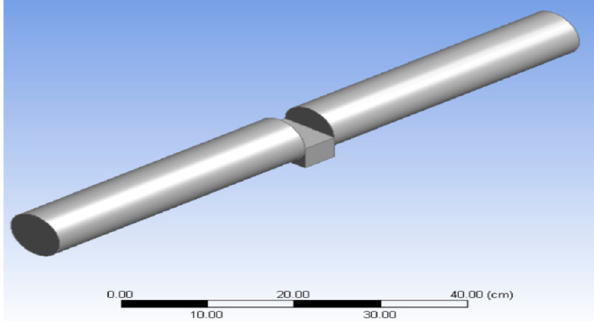
Figure 19. 3D model diagram of the valve. Table 6. Valve specification design